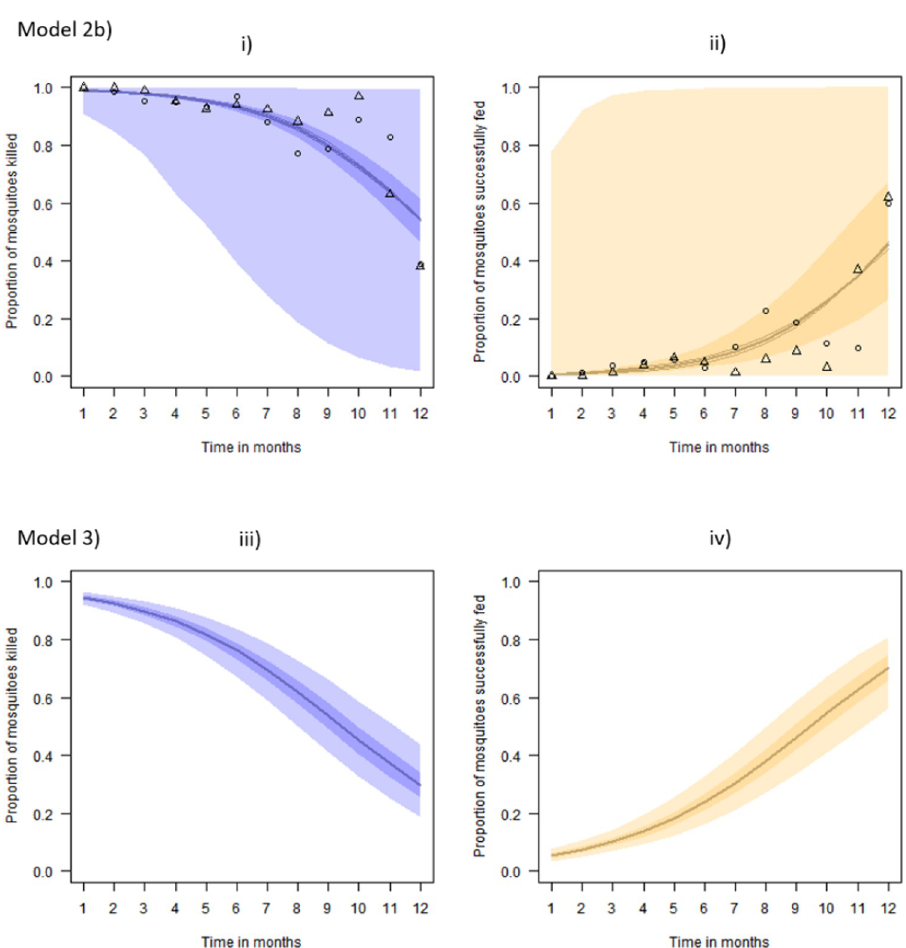
Fig 4. Model predictions of proportion of mosquitoes killed and successfully fed. For the best-estimate (median posterior predictive value) across all study datasets, 50% (darker shaded region) and 95% (lighter shaded region) credible intervals (CrI) from the respective fits to the comprehensive data. Subfigures i) and ii) show results using comprehensive data only (Model 2b), and subfigures iii) and iv) show results using all datasets. Data for the fits are overlaid onto subfigures i) and ii) to demonstrate the suitability of the time-dependent functions. In these fits, the individual study predictions are overlaid on the figures by thin grey lines and noted by matching symbol type for each timeseries. As Model 3 is inferred from both AD and CD sources, there are no data to overlay.